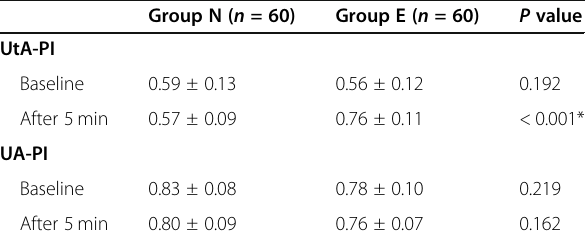
Table 4 Fetal hemodynamic